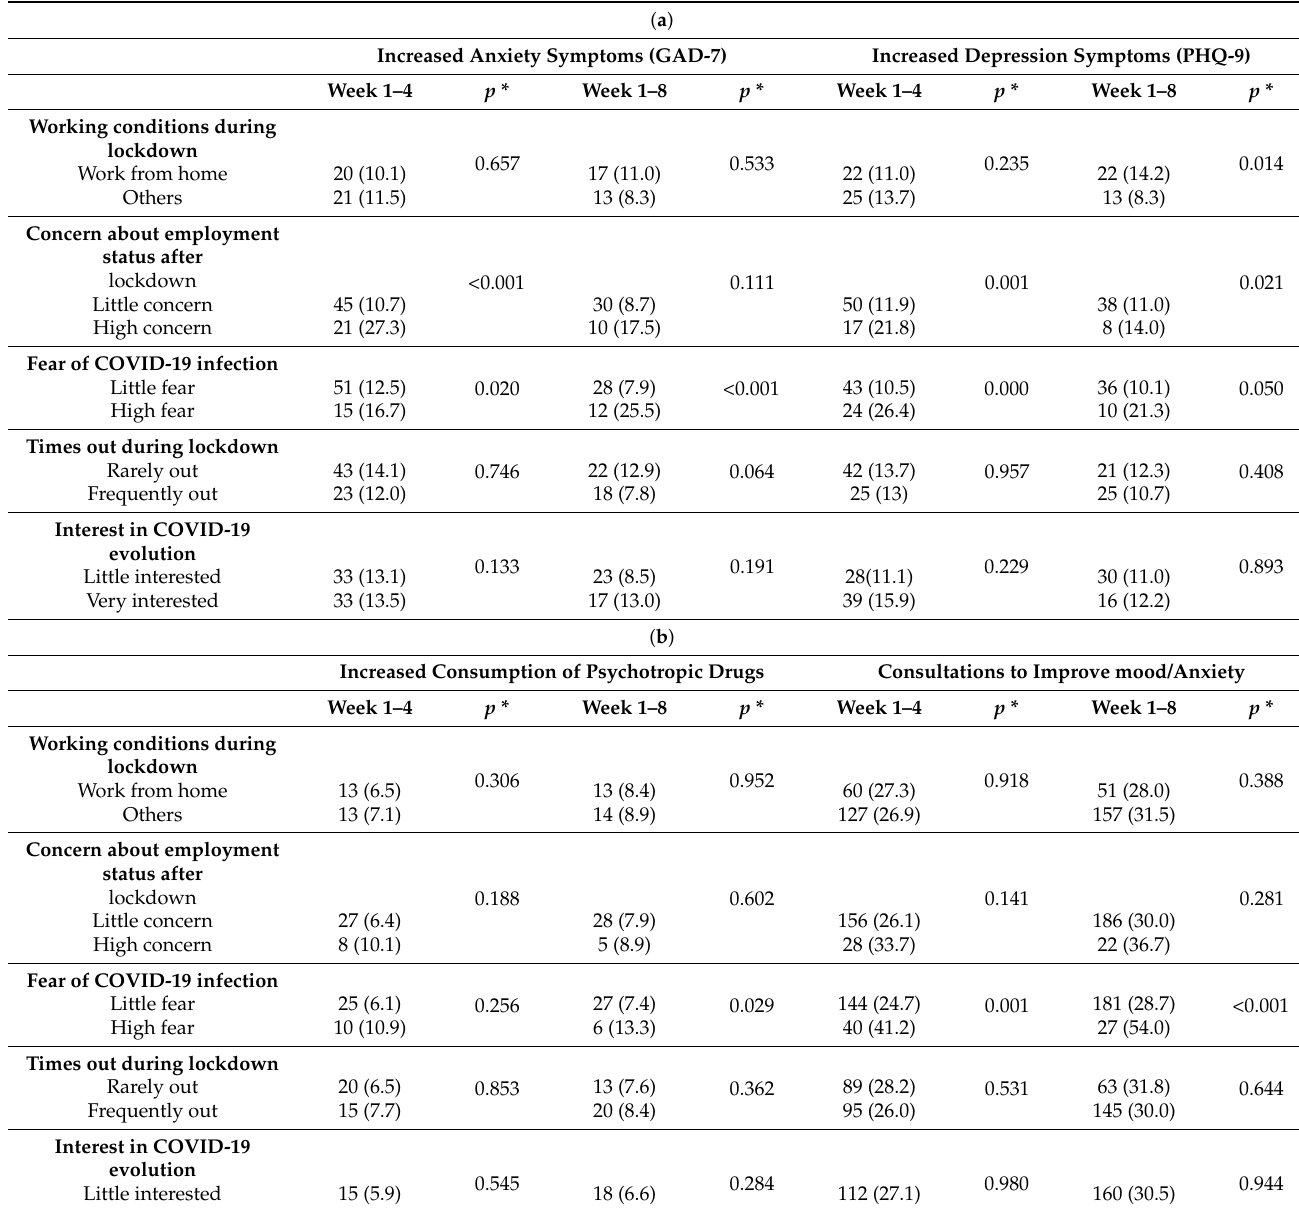
Table 5. Relationship between the situational variables and worsening psychological wellbeing indicators over the eight- week